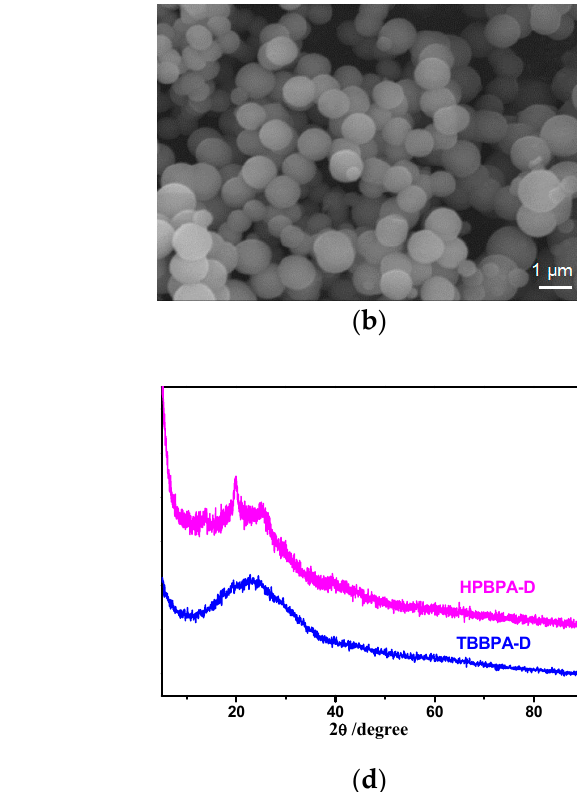
Figure 1. Synthetic route to HBPBA-D and TBBPA-D and 13 C CP/MAS NMR spectra.